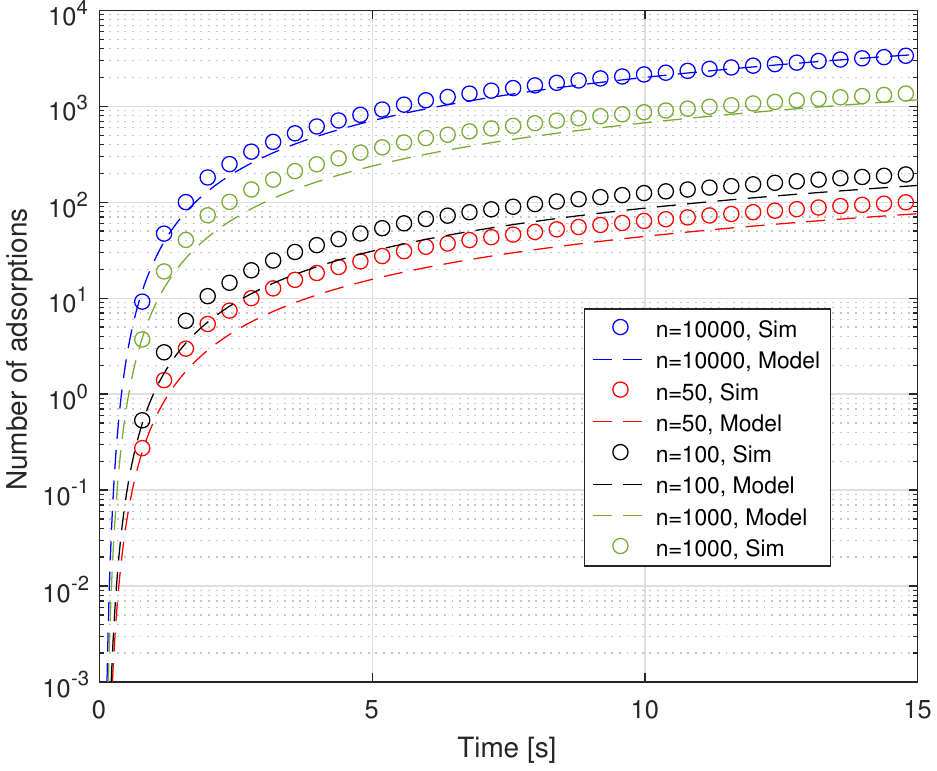
Figure 7. Average absorptions as function of time, with n as parameter, for both the proposed model and particle-based